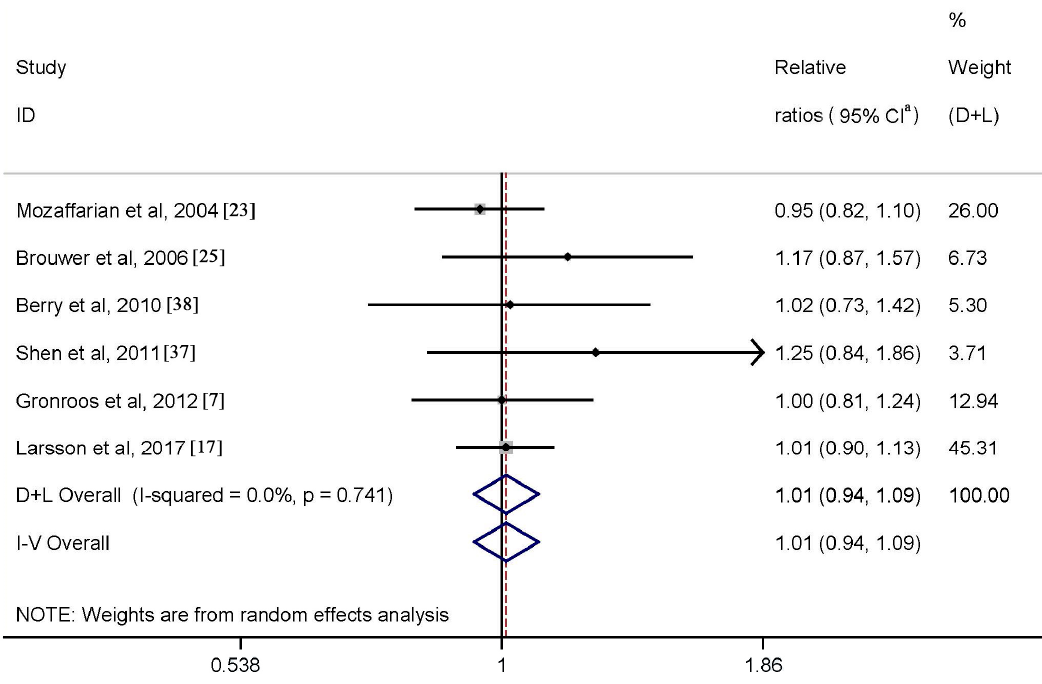
a CI: confidence